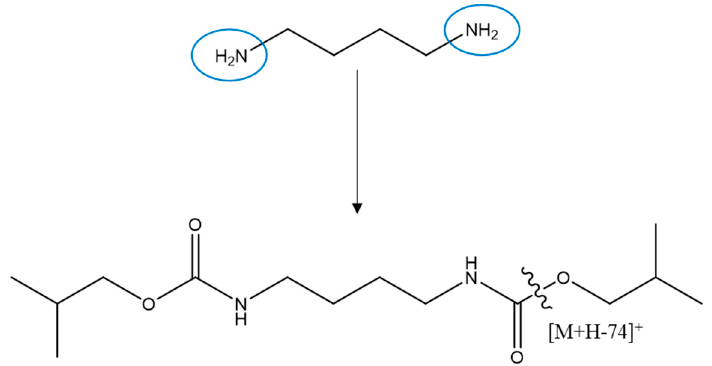
Figure 3. Fragmentation pattern of putrescine upon isobutyl chloroformate derivatization.